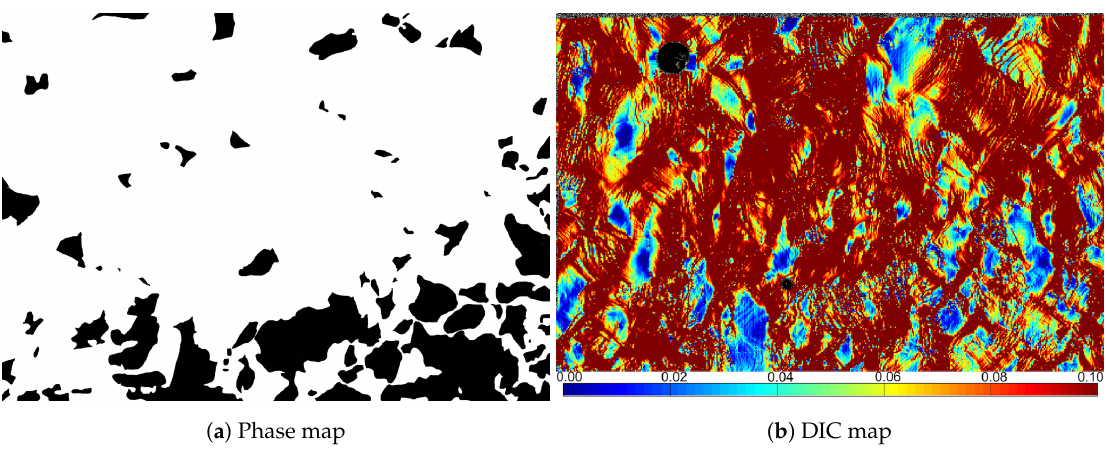
Figure 13. ( a ) A phase map of the same area as analyzed with DIC. The pearlitic phase is black and ferrite is white. ( b ) The same strain map as in Figure 12d with a lower max value for the color